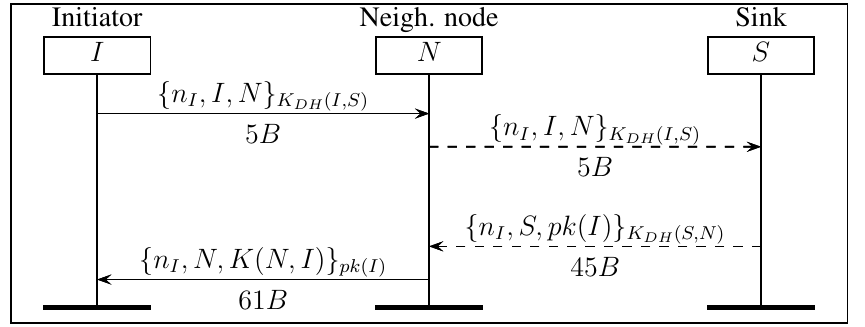
Figure 2. IJS : I joins the network through N . Intermediate nodes between N and S forward messages without any encryption or